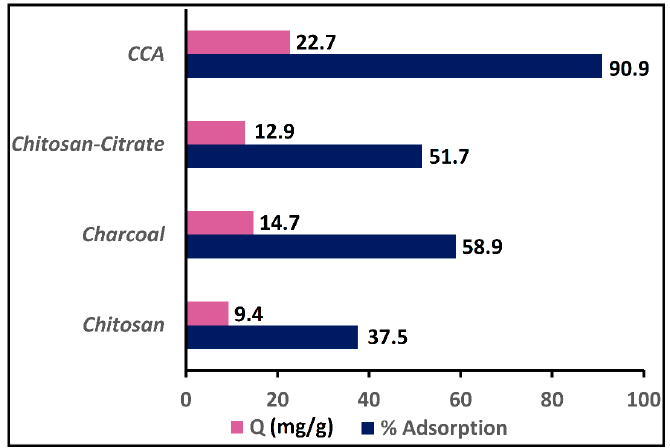
Figure 8. Comparison of various materials for removal of R-16 dye.